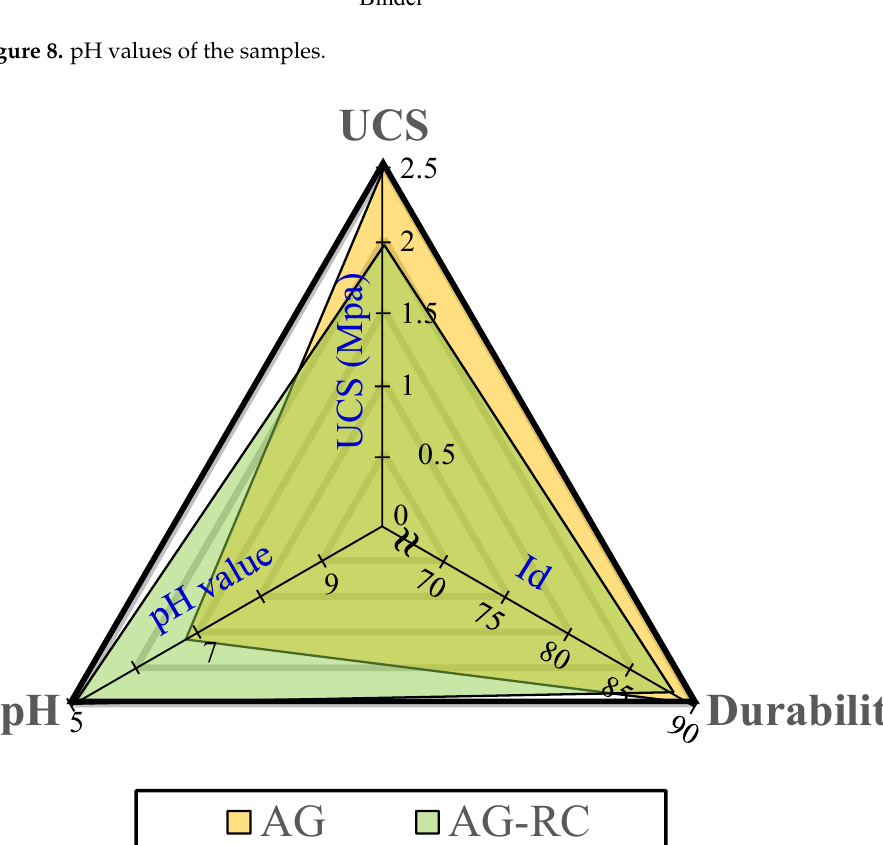
Figure 9. Comparison of the test result of AG and AG-RC sample.